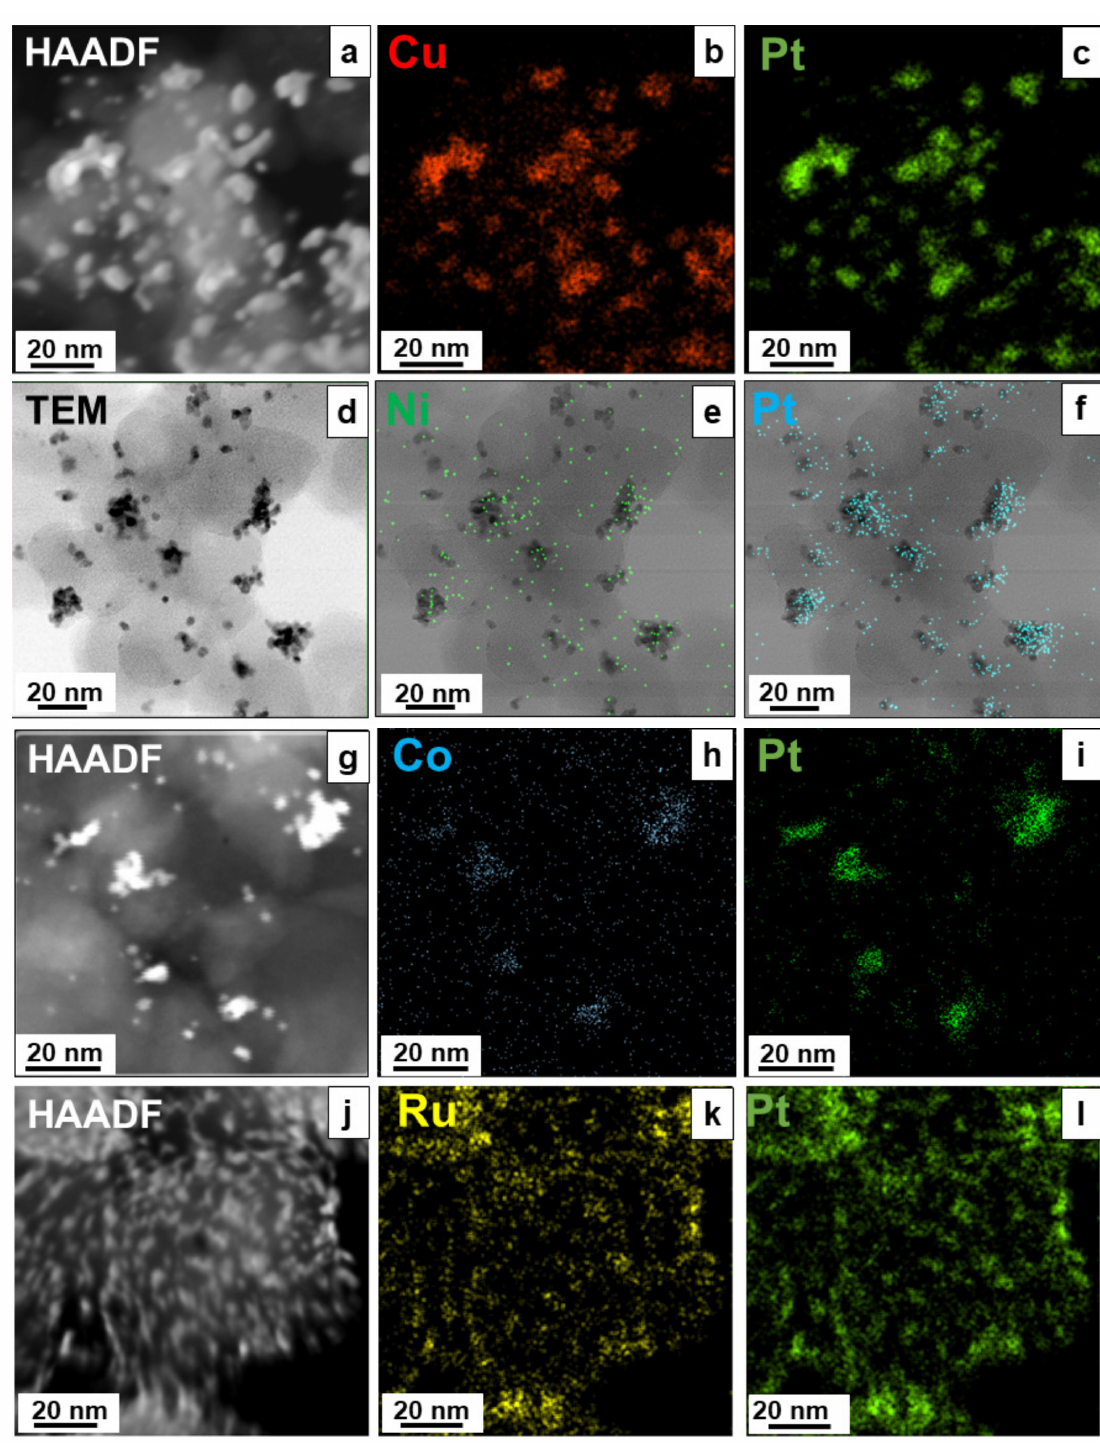
Figure 3. The EDX mapping of the PtM/C sample: the STEM micrographs of a surface section ( a , d , g , j ); the distribution maps of copper ( b ), nickel ( e ), cobalt ( h ), ruthenium ( k ), and platinum ( c , f , i , l ). The study of the PtM/C materials using thermal gravimetric analysis (TGA) and differential scanning calorimetry (DSC) allows both calculating the total content of the metal phase and determining the characteristic temperatures of the beginning of the carbon material’s oxidation and its maximum rate as well as examining the features of this process depending on the composition and the microstructure of the deposited metal NPs